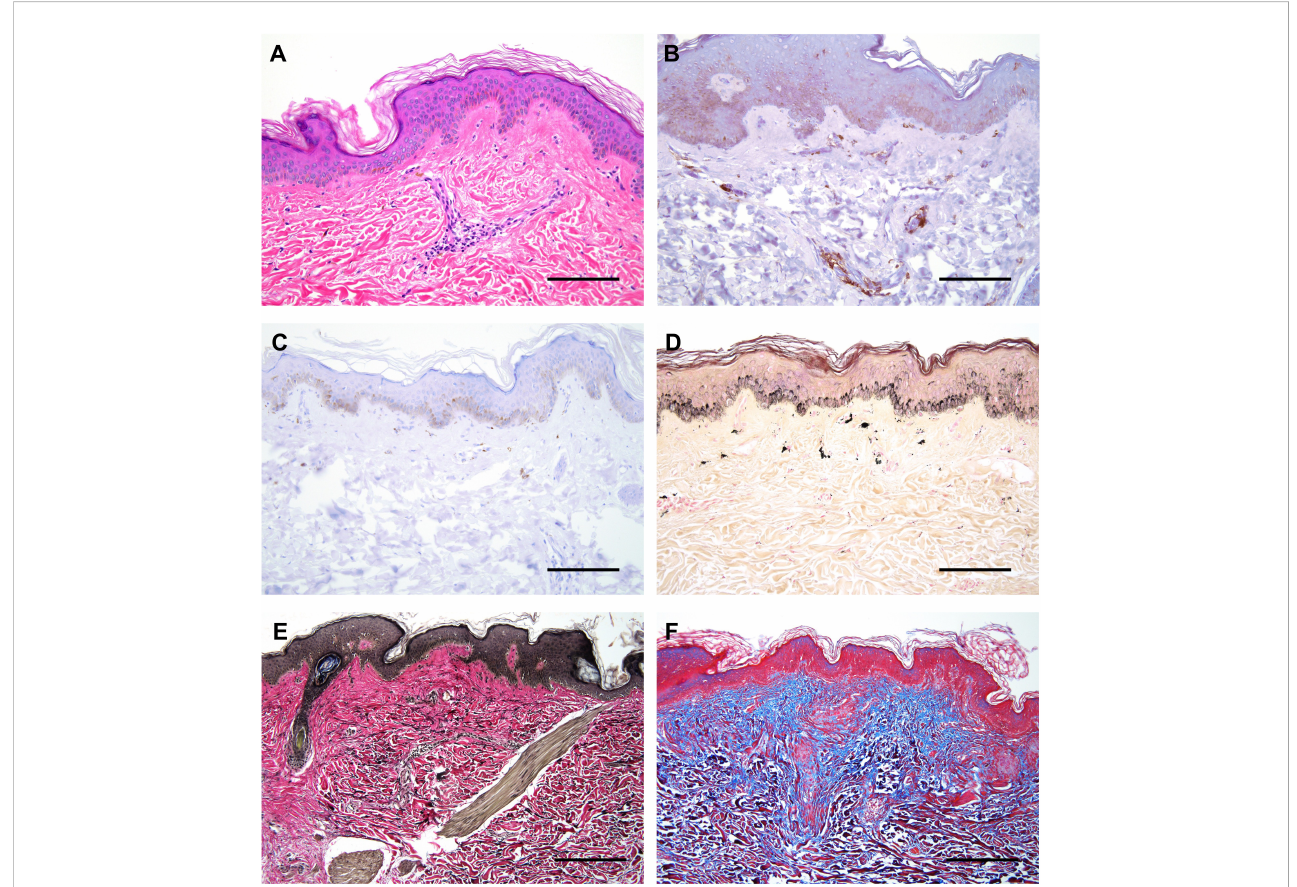
FIGURE 2 Histological features of affected skin in our patient. (A) H&E staining showing mild acanthosis, super fi cial perivascular lymphocytic in fi ltration, and pigmentary incontinence. (B) Double immunostaining with CD4 (brown) and CD8 (red) revealing focal presence of CD4 + T lymphocytes surrounding super fi cial dermal vasculature. (C) Immunostaining with CD20 depicting very few to rare B lymphocytes. (D) Fontana-Masson stain highlighting melanin pigments and melanophages in the super fi cial dermis, termed ‘ pigmentary incontinence ’ . (E) EVG (Verhoff Van Gieson) stain highlighting focally increased density of elastic fi bers in the reticular dermis, corresponding to the region of solar elastosis. (F) Masson ’ s Trichrome stain highlighting mild expansion of the papillary dermal collagen zone (blue areas). All scale bars correspond to 600 m